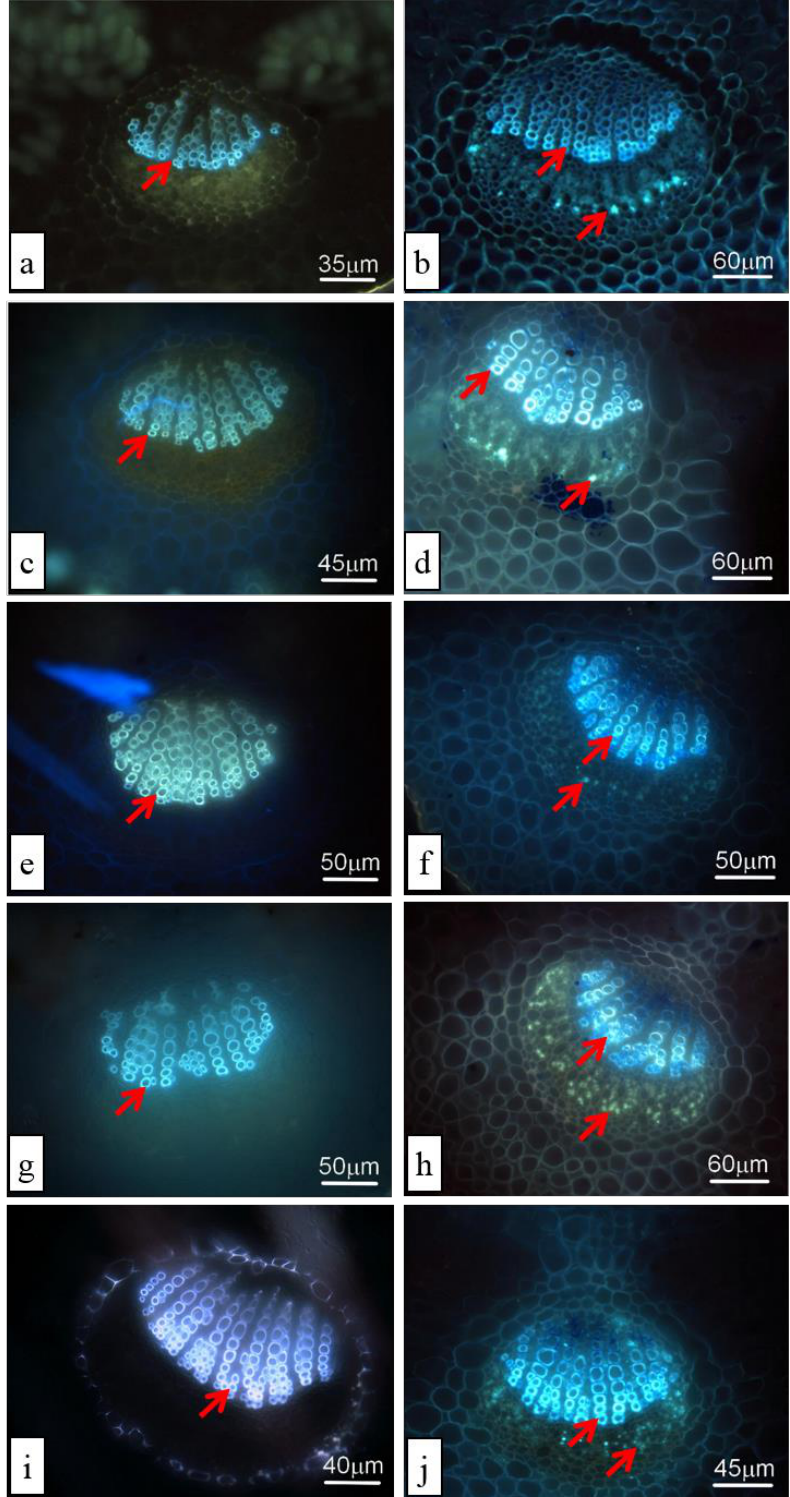
Figure 3. Accumulation of lignin and callose induced by REC3 and 2A1 strains in strawberry plants of cv. ‘Pájaro’. Lignin ( a , c , e , g , i ) and callose deposition ( b , d , f , h , j ) were visualized in foliar tissue of plants treated with water ( a , b ), Fru-SWA ( c , d ), 2A1 and 2A1+Fru-SWA ( e , f , respectively), REC3 ( g , h ), and REC3+Fru-SWA ( i , j ). Arrows point to the vascular bundles of the leaves (xylem and phloem) in callose deposition and the secondary walls of the xylem vessels in lignin deposition. Each micrograph represents a representative example of the five leaflets analyzed coming from five plants.